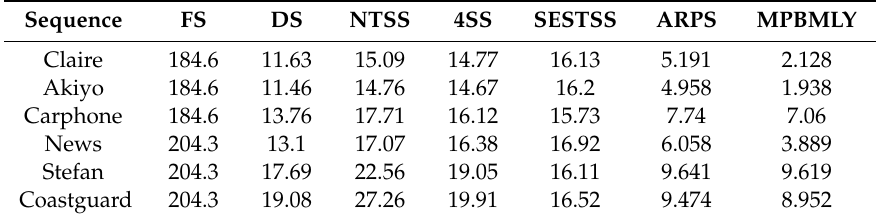
Table 5. Mean number of search points per MB of size 16 × 16. FS, DS, NTSS, 4SS, SESTS, and ARPS correspond to full search, diamond search, new three-step search, four step search, simple and e ffi cient search TSS, and adaptive rood pattern search, respectively.